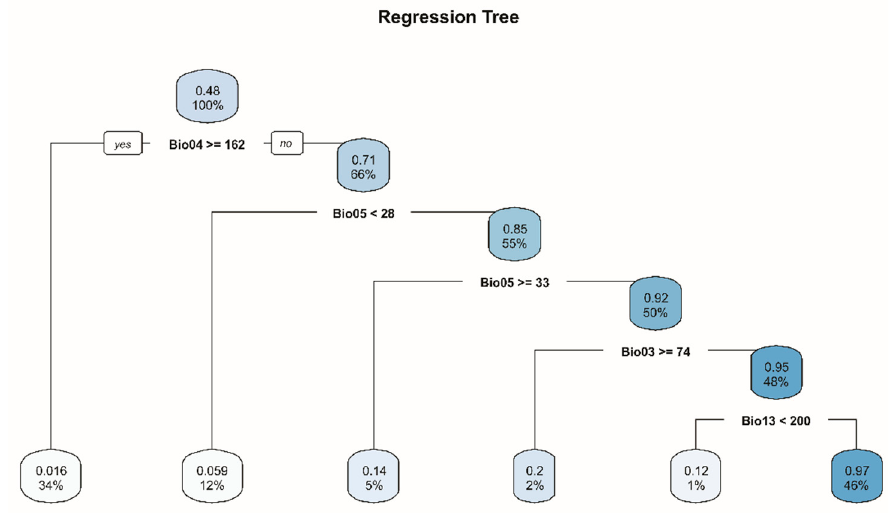
Figure 5. Regression tree for Pinus oocarpa using random forests.